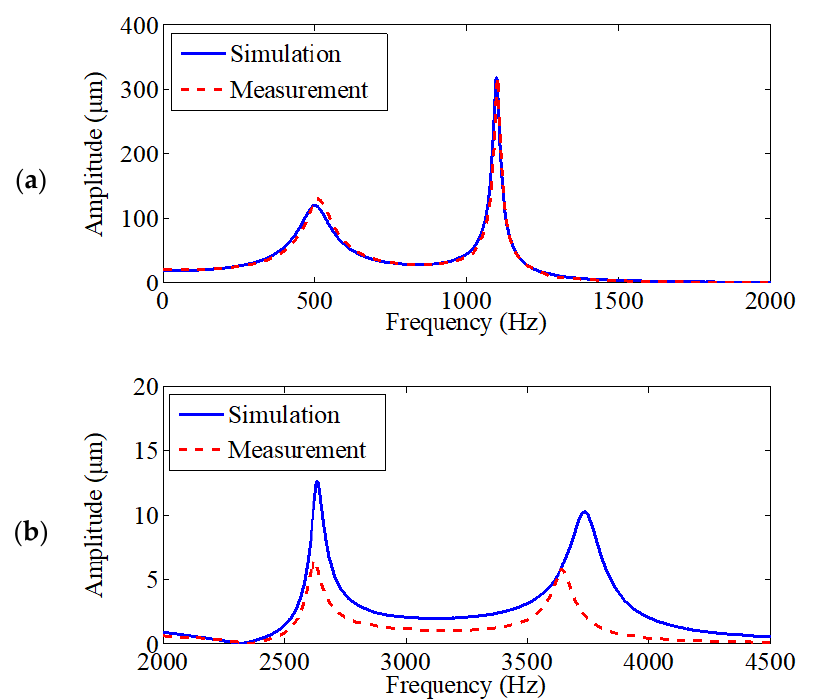
Figure 5. Calculated and tested amplitude–frequency response of torque motor with MF. ( a ) 0~2000 Hz; ( b ) 2000~4500 Hz.